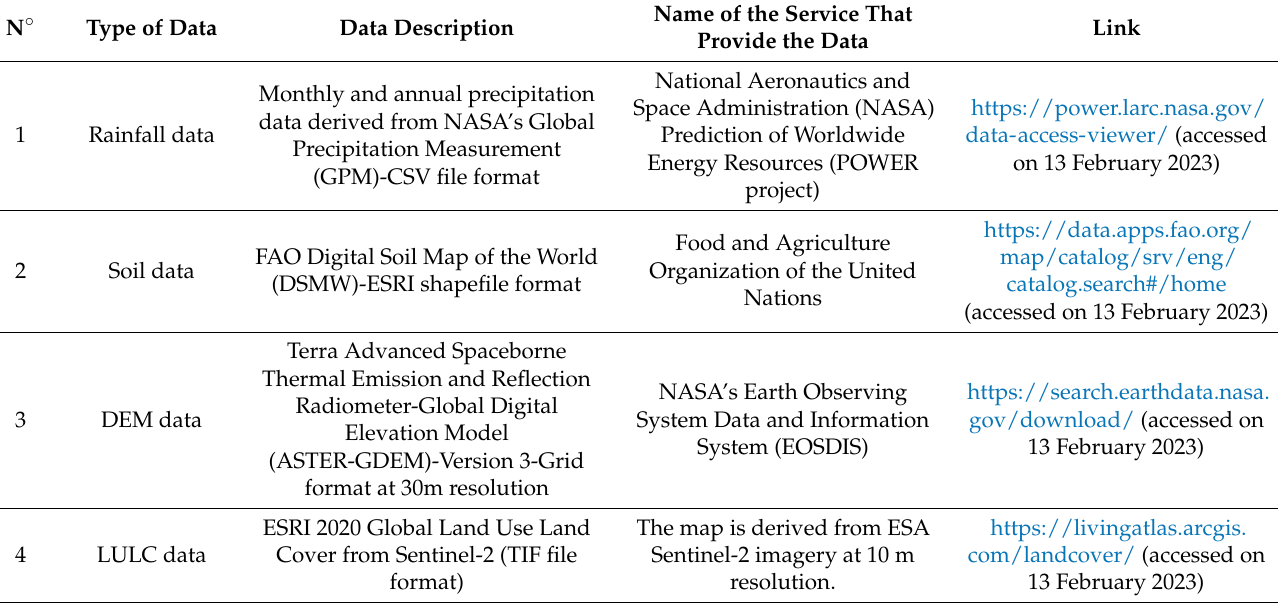
Table A1. Description of the data